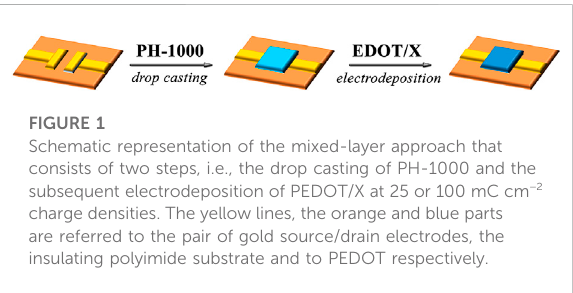
FIGURE 1 Schematic representation of the mixed-layer approach that consists of two steps, i.e., the drop casting of PH-1000 and the subsequent electrodeposition of PEDOT/X at 25 or 100 mC cm − 2 charge densities. The yellow lines, the orange and blue parts are referred to the pair of gold source/drain electrodes, the insulating polyimide substrate and to PEDOT respectively.